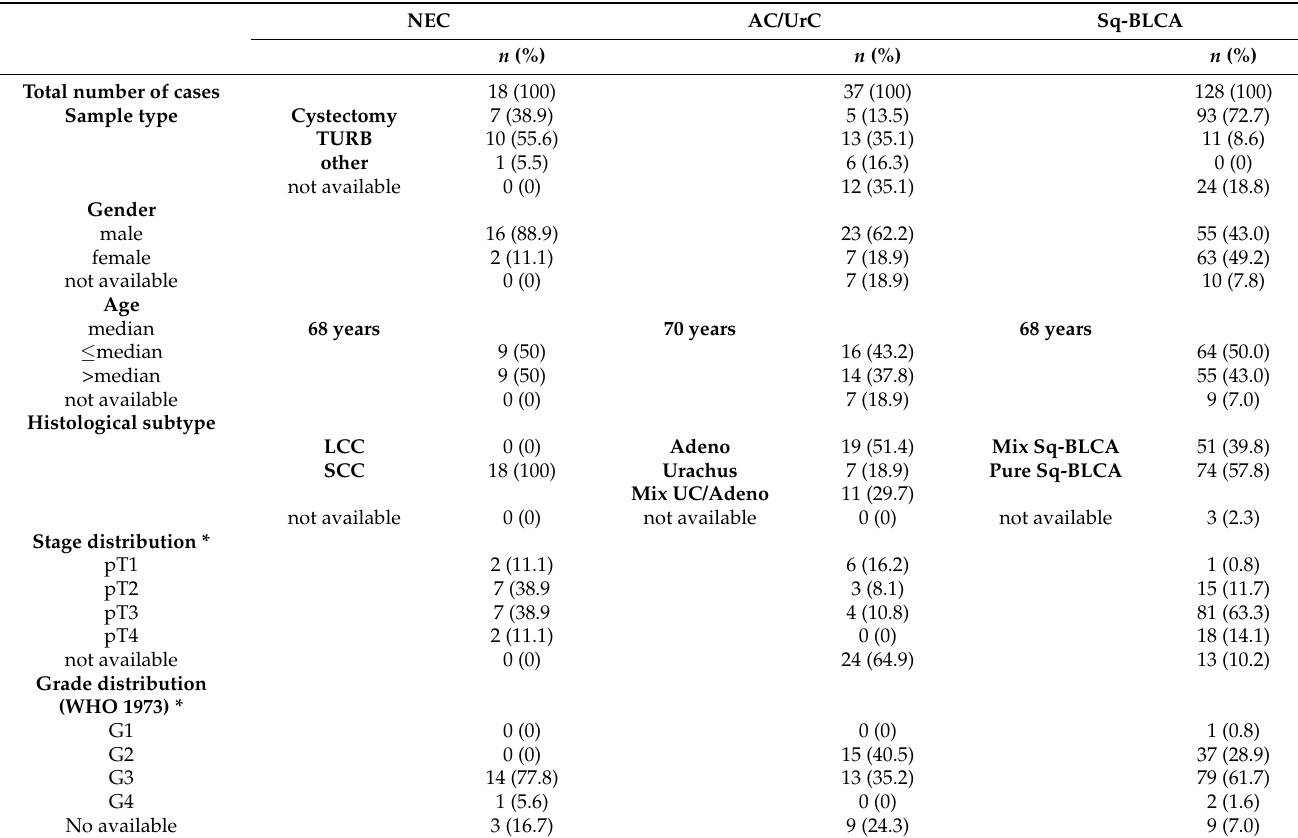
Table 7. Clinical and morphological characteristics.